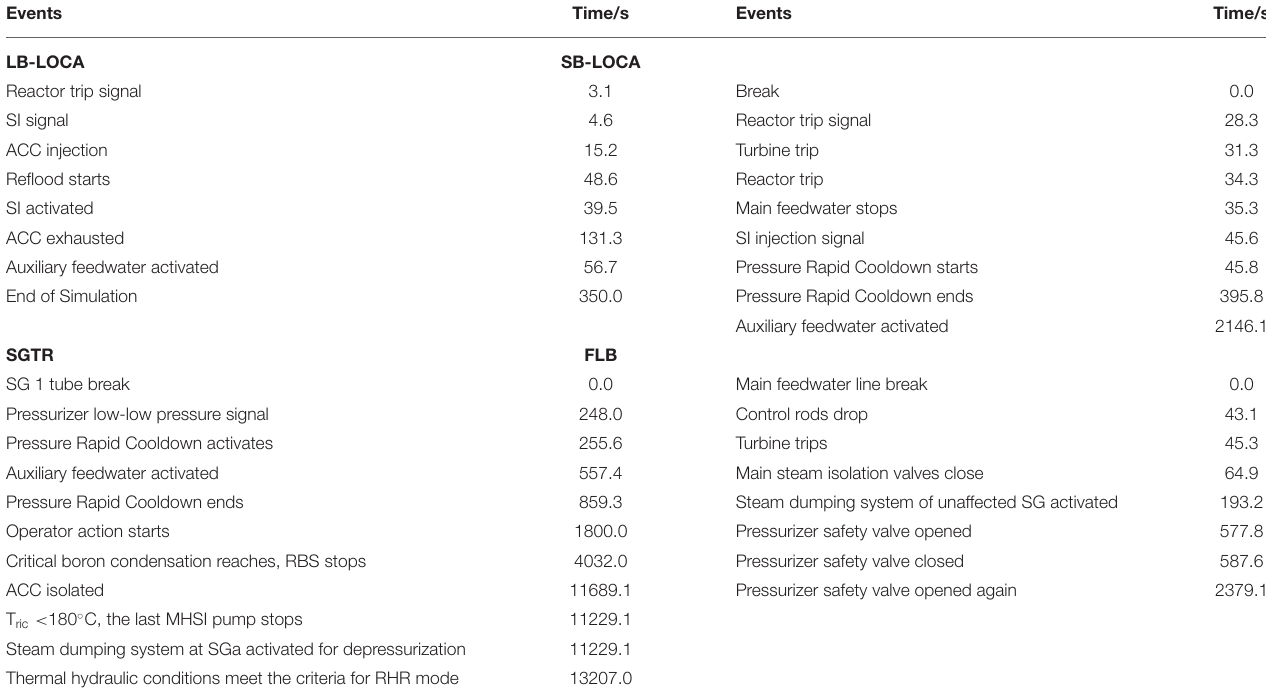
TABLE 4 | Time sequence of key events predicted with ATHLET